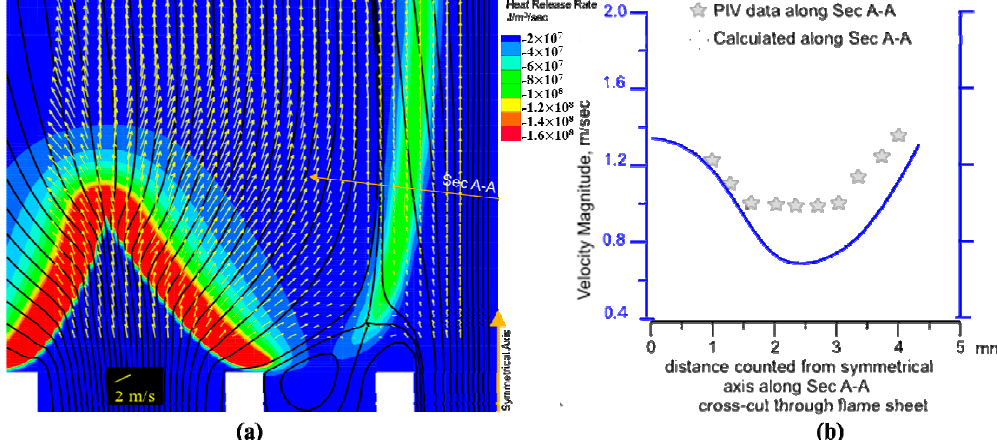
Figure 7. ( a ) Comparison between PIV velocity vectors in yellow and the calculated streamlines in black with the color-coded heat release rate distribution as the background. The burning conditions were for the center flame at ϕ = 0.5 and outer flame at ϕ = 0.88. The average jet exit speed was equal to 1 m / s for both center and outer flames. ( b ) Comparison between PIV data and calculated velocity.